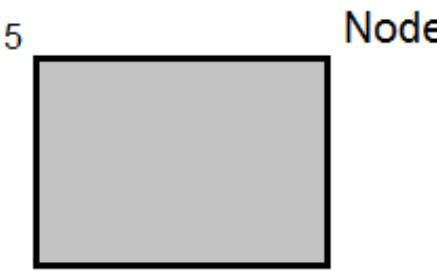
Figure 1. A node of a netgraph including name descriptor and the minimum transfer time (5